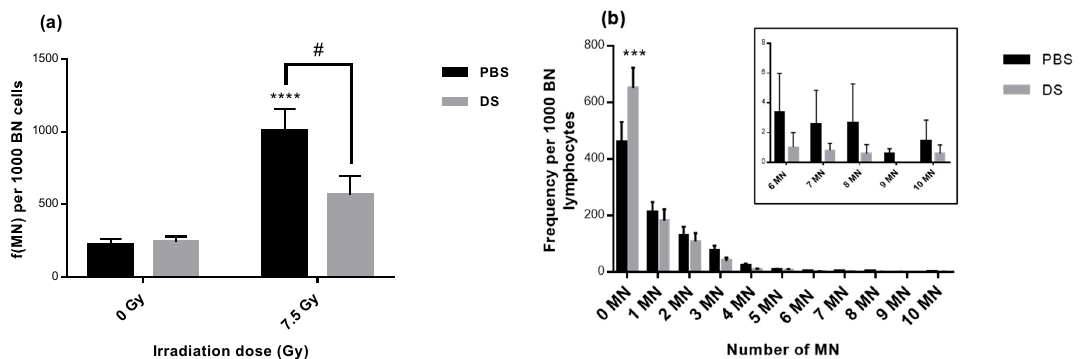
Figure 2. Lymphocyte micronucleus frequency ( a ) and distribution ( b ) at 7.5 Gy in mice irradiated by PBS or DS proton beams in the plateau phase of the Bragg peak. MN: micronucleus, BN: binucleated. Data are depicted as mean values ± SEM. *** for p < 0.0005 and **** for p < 0.0001 for irradiated samples compared to non-irradiated ones and # for p < 0.05 for DS compared to PBS. Each experiment was performed in triplicates.